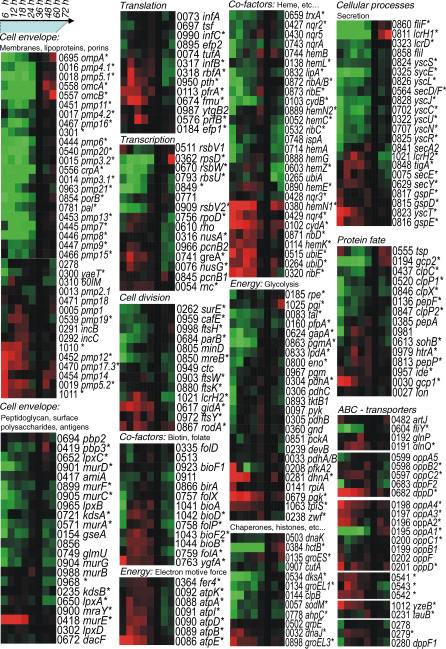
Functional Grouping and Cluster AnalysisDetailed expression profiles of functionally related sets of genes. Clusters were created using SOM cluster analysis using the color scale as described for Figure 1. Genes that were calculated as significantly regulated using SAM 2.0 are indicated with an asterisk. For a more detailed view, see Table S3A. Gene identification numbers, gene definitions, and gene names can be viewed at http://www.ncbi.nlm.nih.gov.